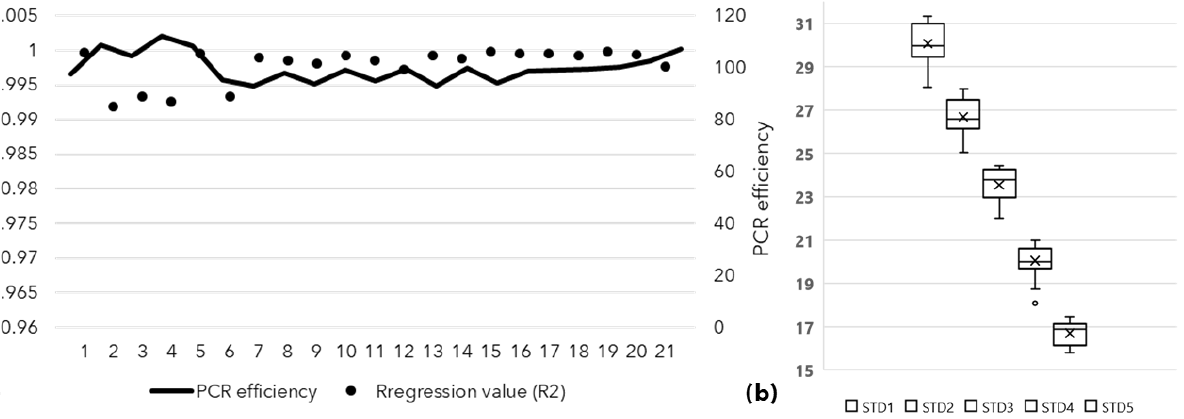
Figure 6. The PCR efficiency and regression (R 2 ) values from nested qPCR assays distributed in 21 qPCR plates, ranged from 90 to 110 and close to 0.99, respectively ( a ); the graph showing mean and standard deviations of Ct values derived from serially diluted, (10 –3 to 10 –7 ; STD 1 to STD 5), purified, quantified 75 bp amplicon used to plot the standard curve across 21 qPCR plates ( b ).